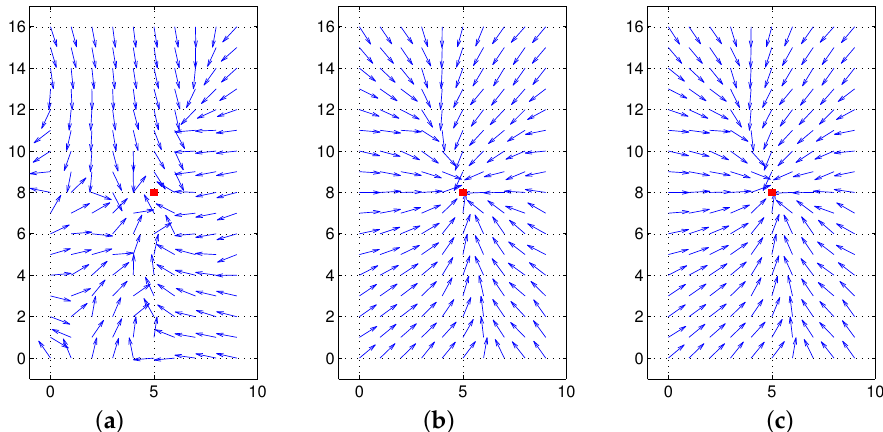
Figure 13. Homing performance for Vardy’s image environment with a reference compass: ( a ) moment model only with color intensity; ( b ) moment model only with estimated distance; ( c ) moment model with estimated distance and color intensity; distance is estimated using the ground line in the image without the laser sensor (the arrow indicates the homing direction).